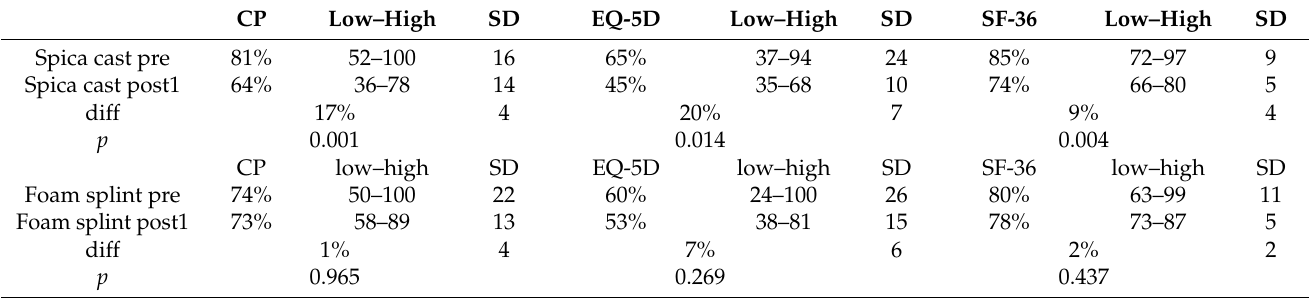
Table 4. Comparison of pre- and postoperative QOL scores, split up by mode of immobilization.